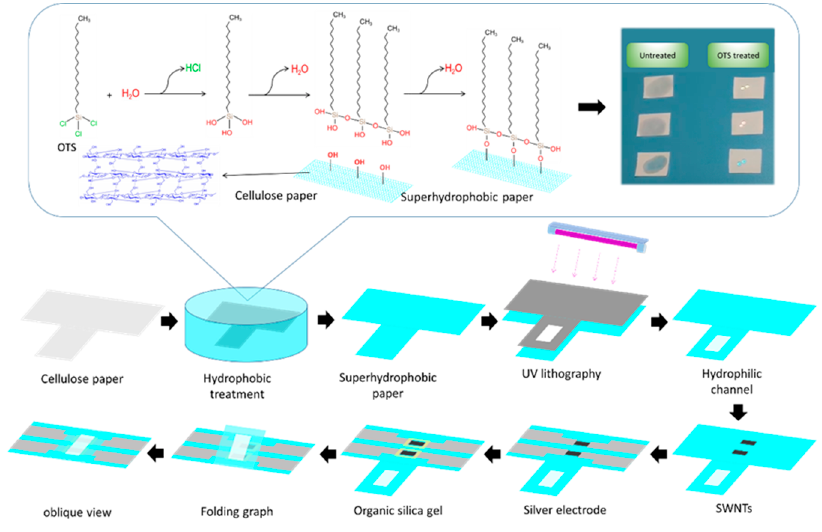
Figure 4. Preparing process of Dual-MFB structure using superhydrophobic cellulose paper, UV lithography, and screen-printing technology.